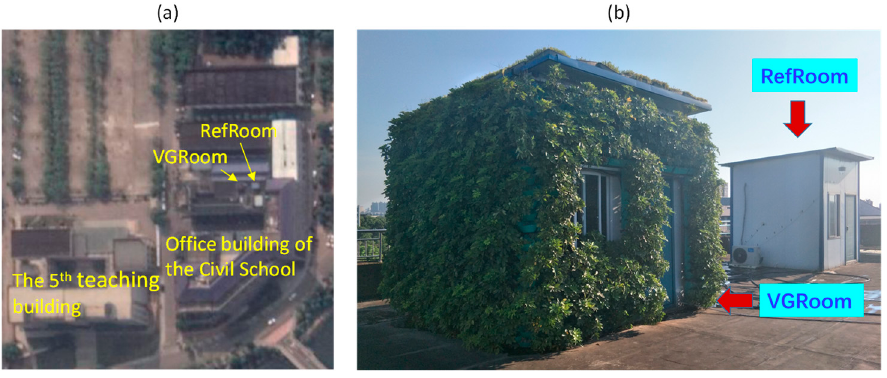
Figure 1. Location on the map ( a ) and photograph ( b ) of the experimental setup.